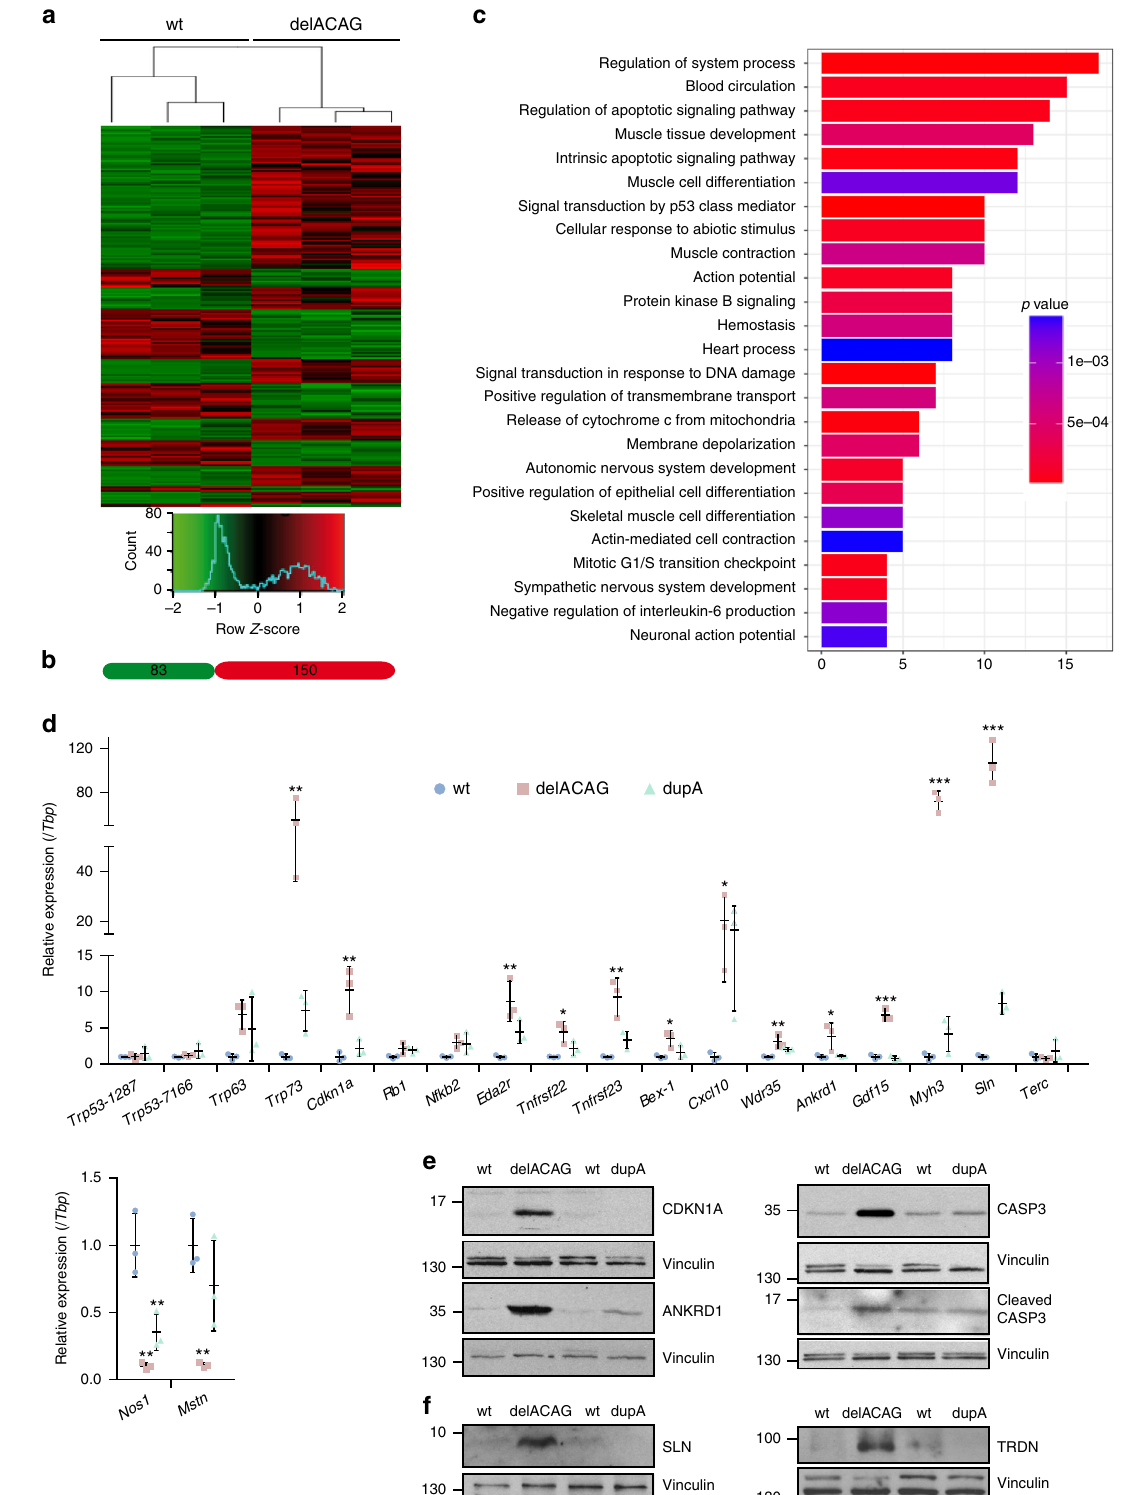
edu/EVS/]. The potential effect of SNVs were predicted using Polyphen and SIFT. Array based comparative genomic hybridization (aCGH) in patients from family 2 was conducted in DNA isolated from lymphoblast cell lines (LCL) using an in- house-designed 8× 60k genome-wide oligonucleotide custom array with an average probe spacing of 43 kb (KaryoArray ® v3.0; Agilent-based; Agilent Technologies). Hybridization experiments were performed as recommended by the manufacturer (Agilent Technologies). Analysis and visualization of Karyoarray ® was achieved with Genomic Workbench Standard Edition 5.0 software (Agilent